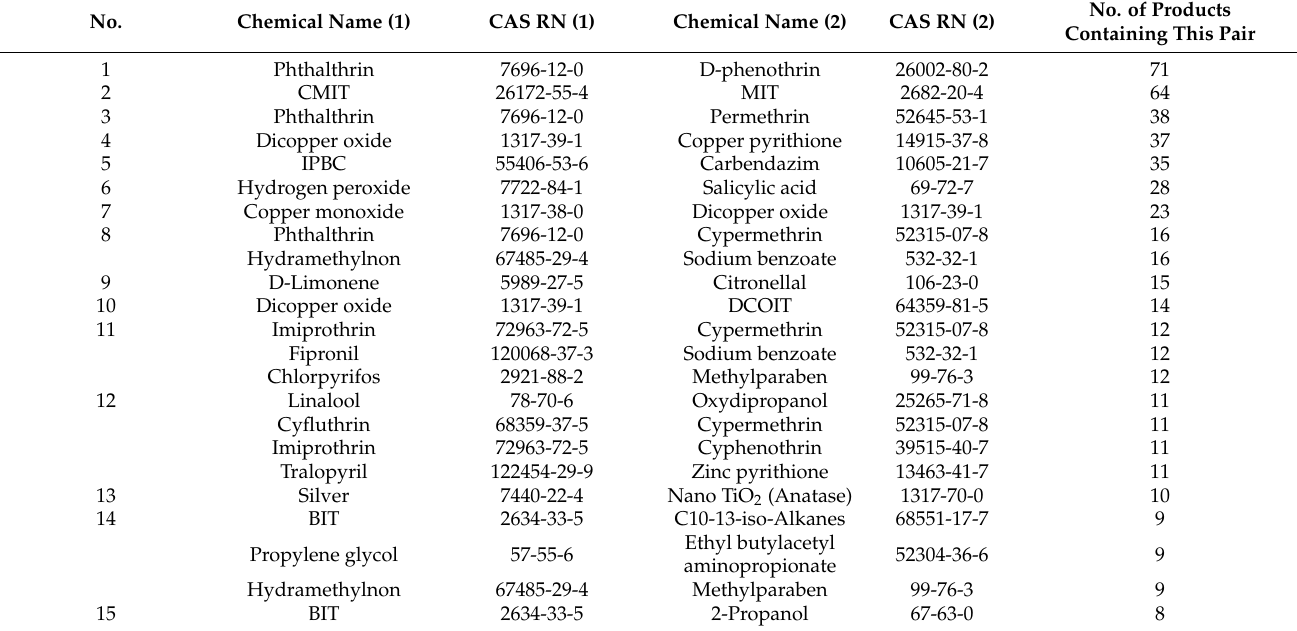
Figure 3. Distribution of the number of biocides in the mixture combinations investigated in the combined inhalation exposure scenarios data of biocides in South Korea ( a ) biocidal products; ( b ) household chemical products. Table 3. Chemical name and CAS registry number (RN) of Top 15 1 most frequently occurring binary mixtures of biocides from the combined inhalation exposure scenarios database in South